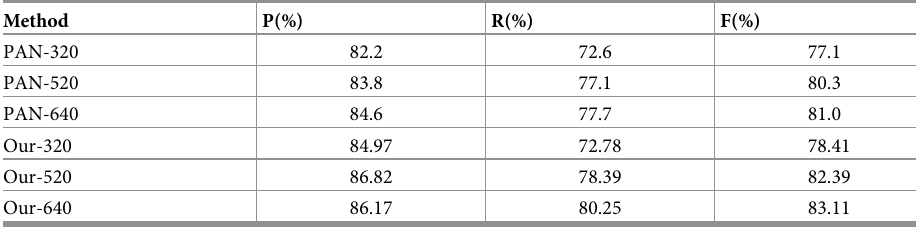
Table 2. The results of our experiments at different scales on the CTW1500 dataset.